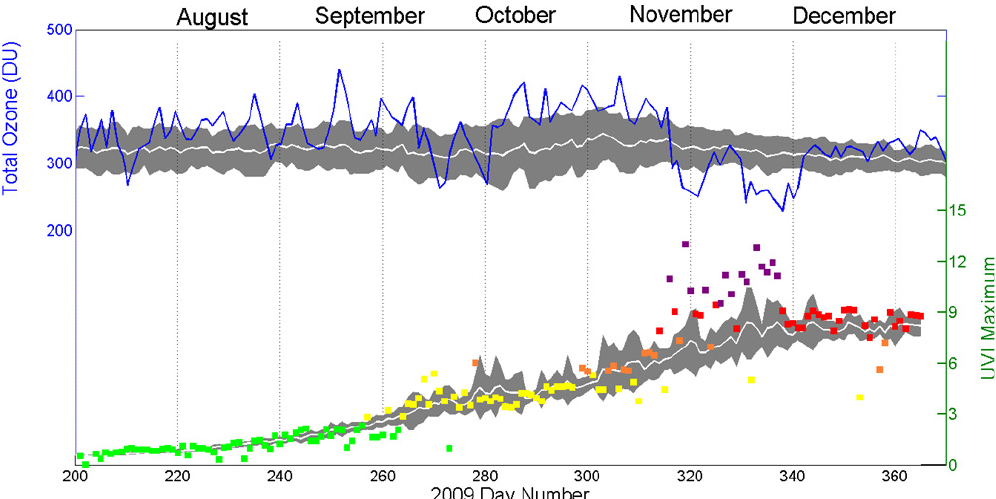
Fig. 6. Temporal evolution of daily maximum UV index (UVI) at ground surface for CEILAP-RG site (colored squares, lower panel, right axis). White line is the climatological daily mean of UVI (see text for explanation) and shadow area corresponds to ± 1SD. Temporal evolution of total ozone for R´ıo Gallegos site (blue line, upper panel) with the climatological daily mean of total ozone (white line, upper panel). Shadow area corresponds to ± 1SD.